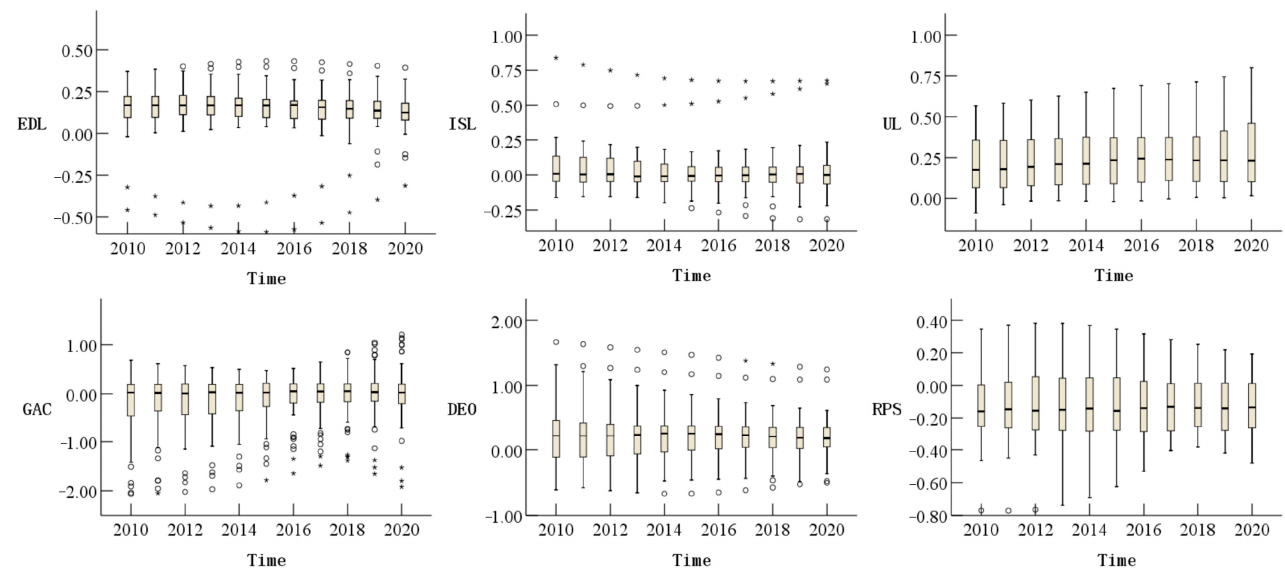
Figure 8. Time series change of regression coefficients of each impact factor from 2010 to 2020.